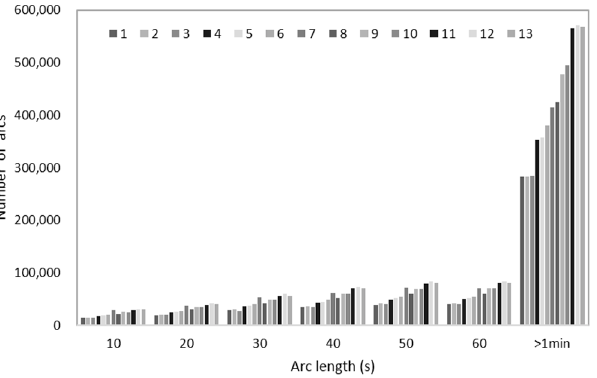
Figure 11. Observable arc length distribution of the different constellation configurations.